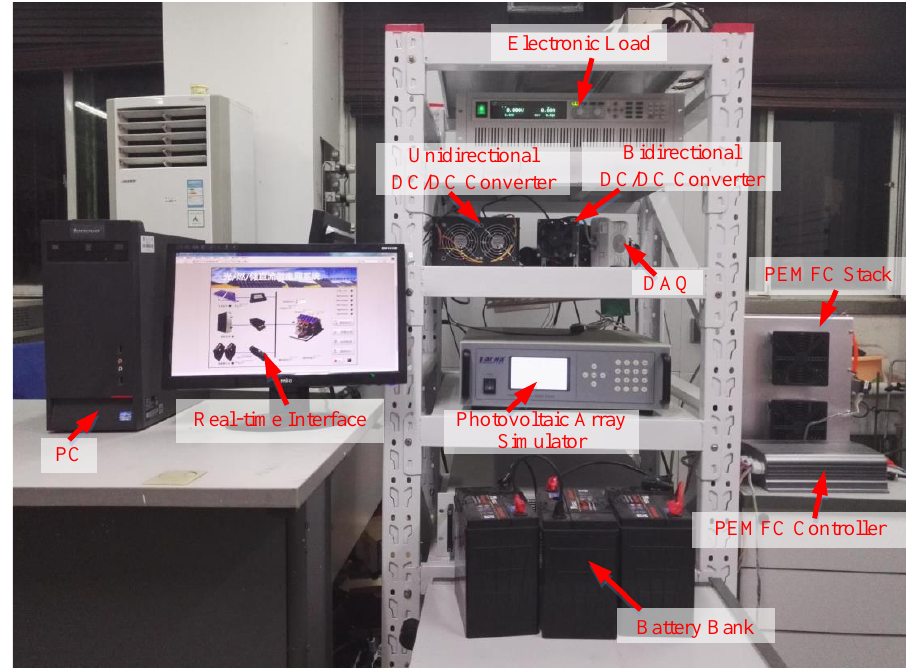
Figure 8. General view of the experimental test setup.